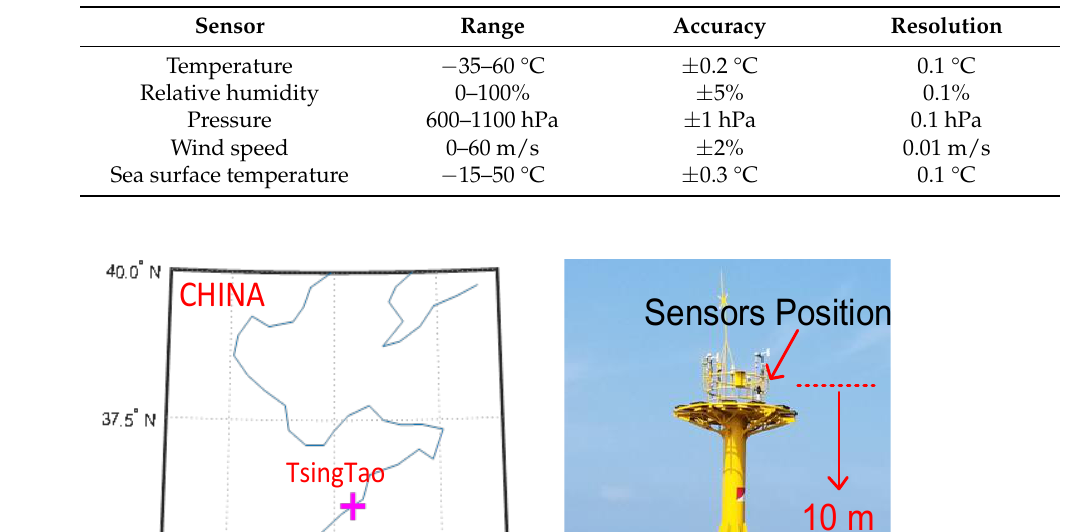
Table 1. Sensor parameters.